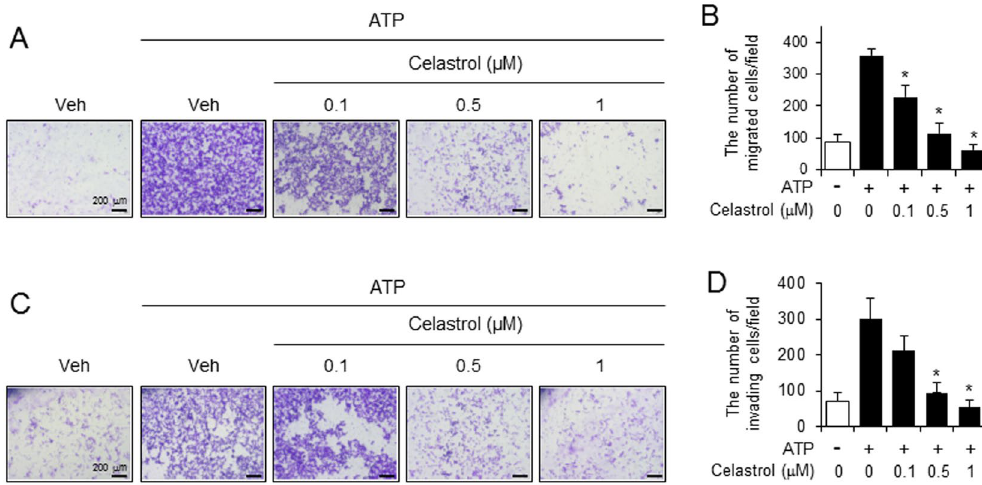
Figure 6. Celastrol treatment reduces the potency of macrophages to stimulate the metastatic potential of melanoma cancer cells. LPS-primed primary mouse macrophages were stimulated with ATP (5 mM) for 1 hr in the presence or absence of celastrol. Conditioned culture supernatants were collected and added to the bottom chambers of transwells which had B16F10 cells plated in the upper chamber. After 24 hr, cell migration and invasion were determined. ( A ) Images of B16F10 cell migration. ( B ) The number of migrating B16F10 cells was counted in the microscopic field. ( C ) Images of B16F10 cell invasion. ( D ) The number of invading B16F10 cells was counted in the microscopic field. Values are means ± SEM (n = 5) for B and D. * Significantly different from ATP alone, p <